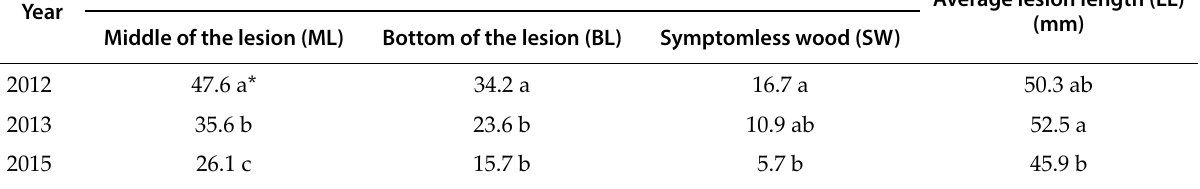
Table 3. Mean proportions (%) of Phaeomoniella chlamydospora colonies recovered from middle of lesion, bottom of the le - sion, or from symptomless wood, and mean lesion lengths, from grapevines inoculated in 2012, 2013 and 2015 (all isolates, and cultivars).